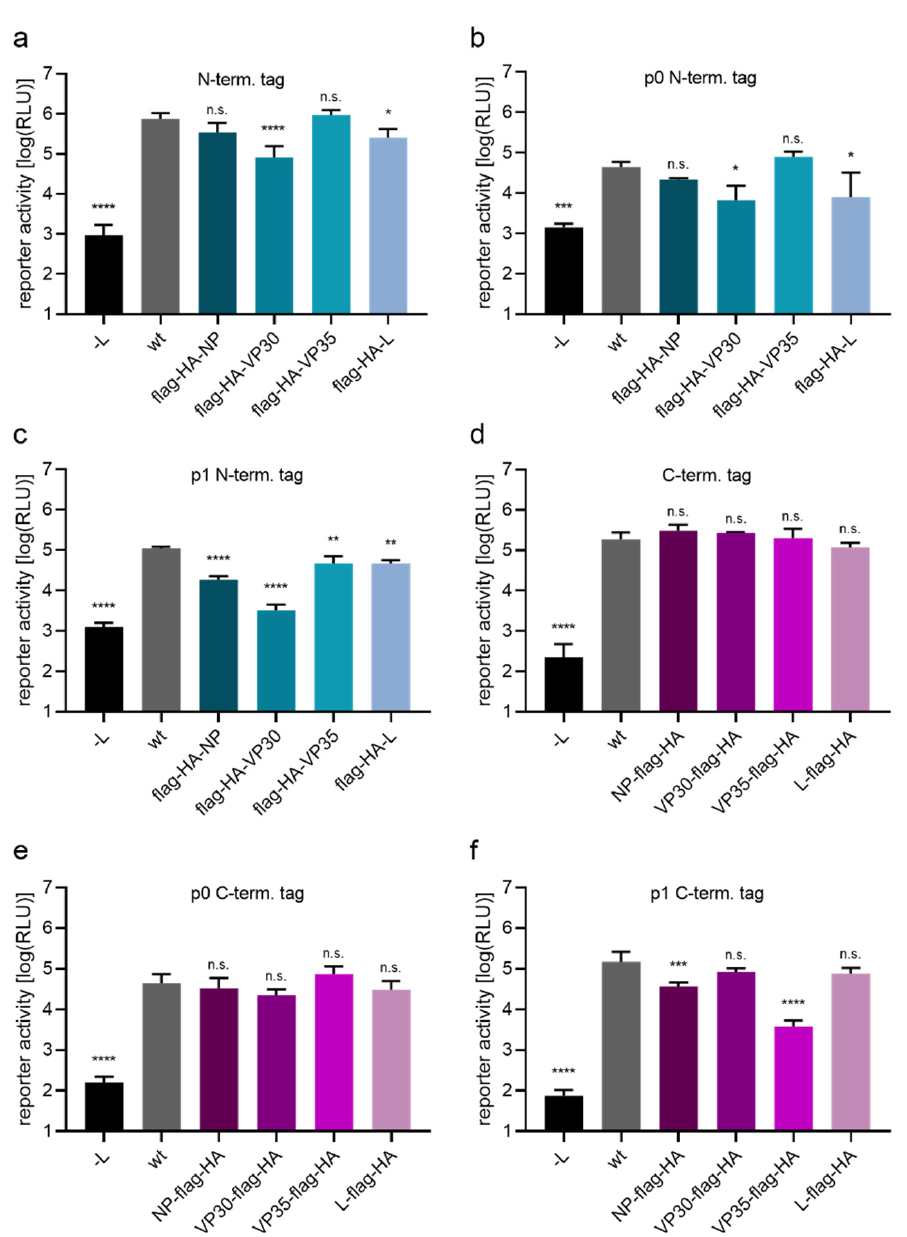
Figure 1. Functionality of flag-HA tagged EBOV proteins. ( a – c ) N-terminal tagging of RNP proteins. 293T cells were transfected with all necessary plasmids for a 1- or 4-cis minigenome assay, encoding either untagged RNP proteins (wt) or flag-HA-tagged version as indicated. As a negative control the polymerase L was omitted and replaced by empty vector (-L). Reporter activities in a 1-cis minigenome assay ( a ) or p0 cells ( b ) or p1 cells ( c ) of a 4-cis minigenome assay are shown. ( d – f ) C-terminal tagging of RNP proteins. 293T cells were transfected as described in ( a – c ). Reporter activity in a 1-cis minigenome assay ( d ) or p0 cells ( e ) or p1 cells ( f ) of a 4-cis minigenome assay are shown. Means and standard deviation of four ( a , d – f ) or three ( b , c ) biological replicates are shown. Significant differences compared to wt are indicated: n.s.: not significant; *: p < 0.5; **: p < 0.01; ***: p < 0.001; ****: p < 0.0001.